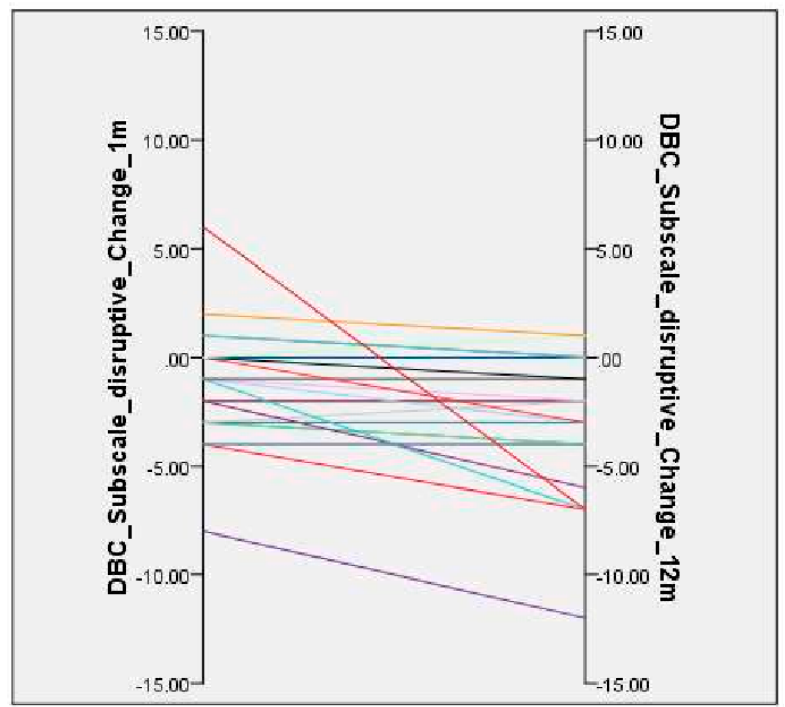
Figure A3. Individual scores on the Developmental Behaviour Checklist for Adults (DBC-A) subscales at baseline and at 12 months: Disruptive Behaviour Scale. Brain Sci. 2020 , 10 , x FOR PEER REVIEW